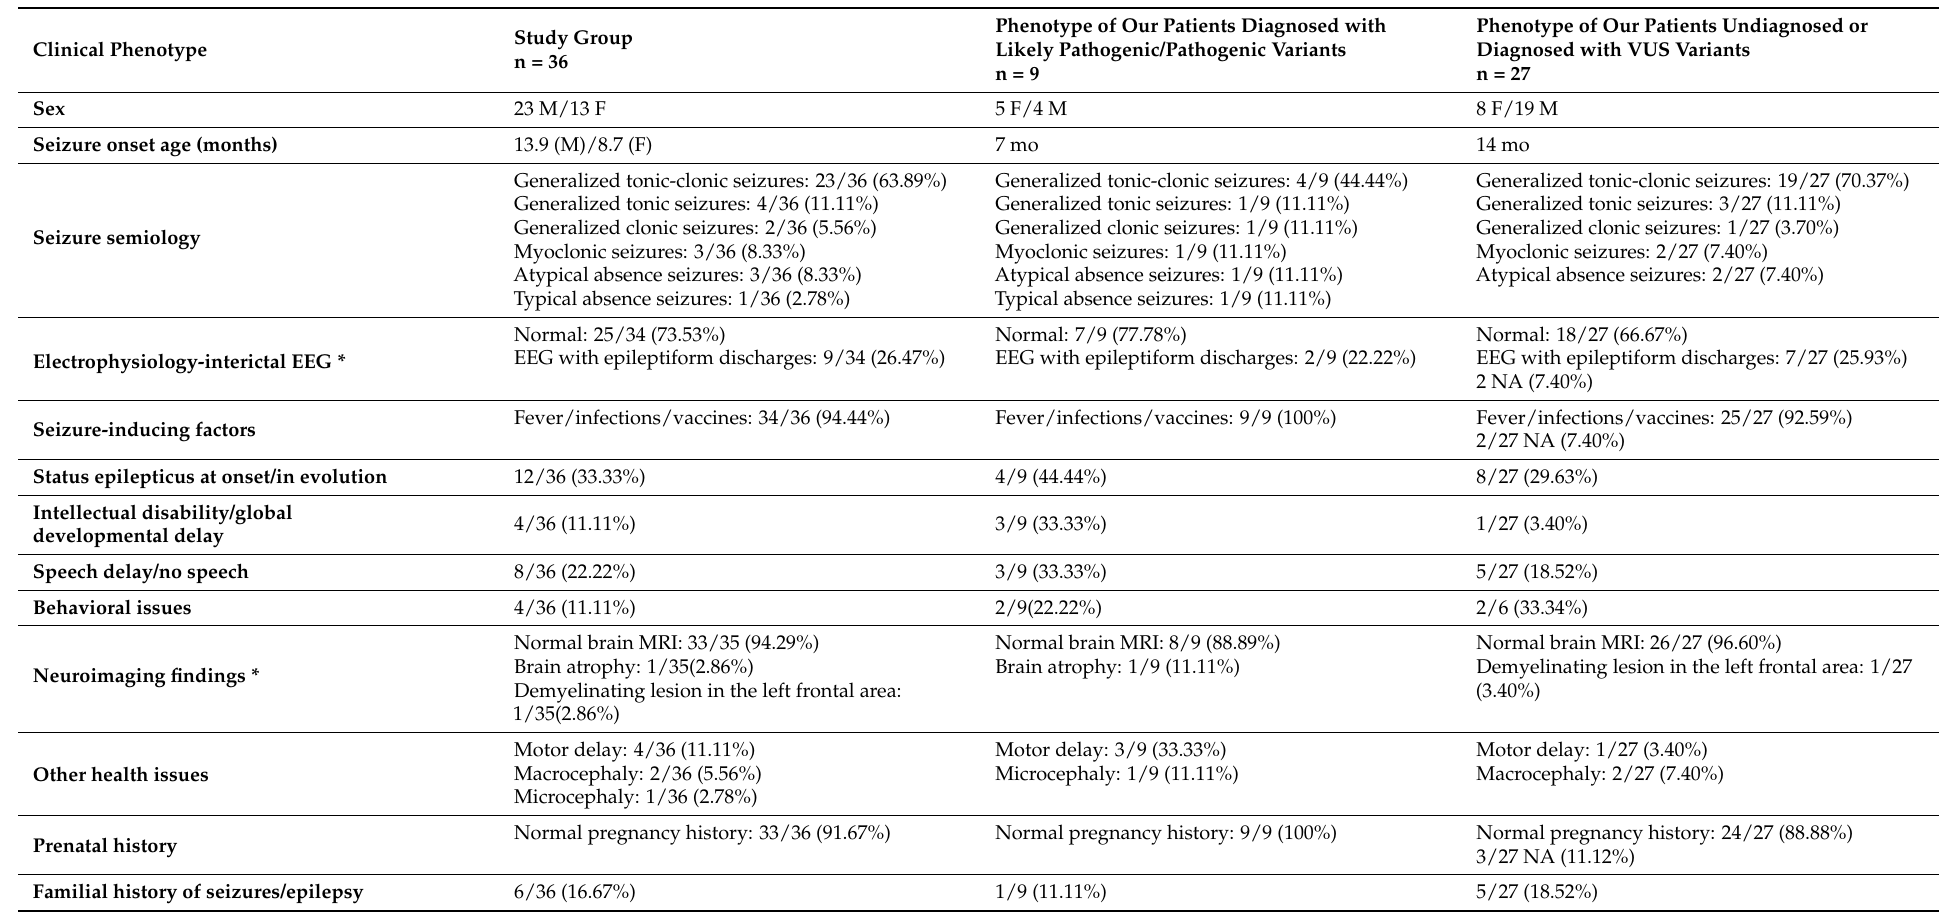
Table 1. Neurological features and genetic findings of the tested patients: the study group, then segregated by genetic findings, with variants in the SCN1A gene and with variants in other